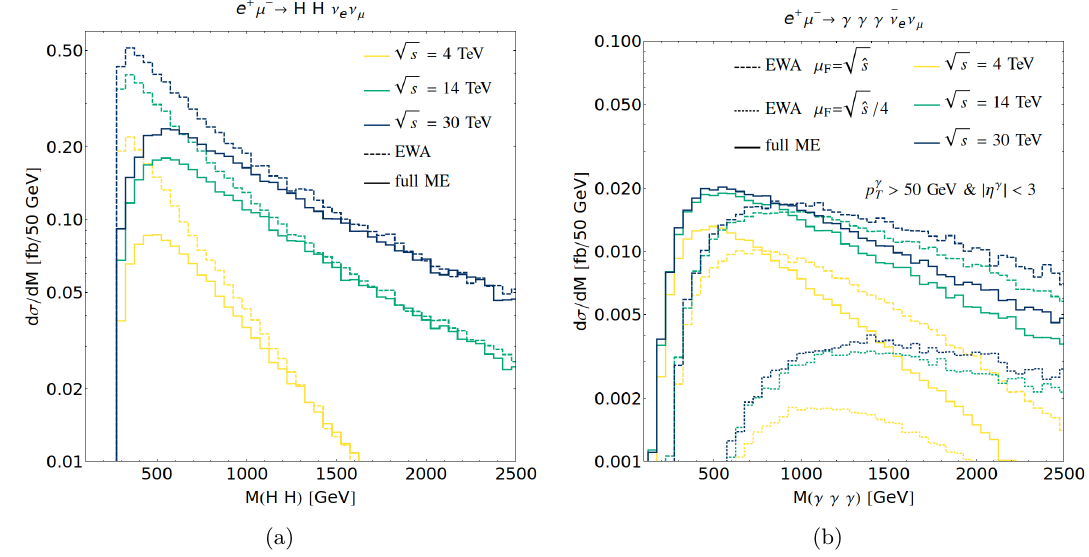
Figure 3 . (a) The invariant mass distribution M ( HH ) of the process W + W − → HH , as predicted by the full 2 → 4 ME (solid) and the EVA W + curves) and 14 TeV (upper dark curves). (b) Same but for the M ( γγγ ) distribution of the process W + W − → γγγ , assuming the fiducial cuts in eq. (4.4), and for the W +